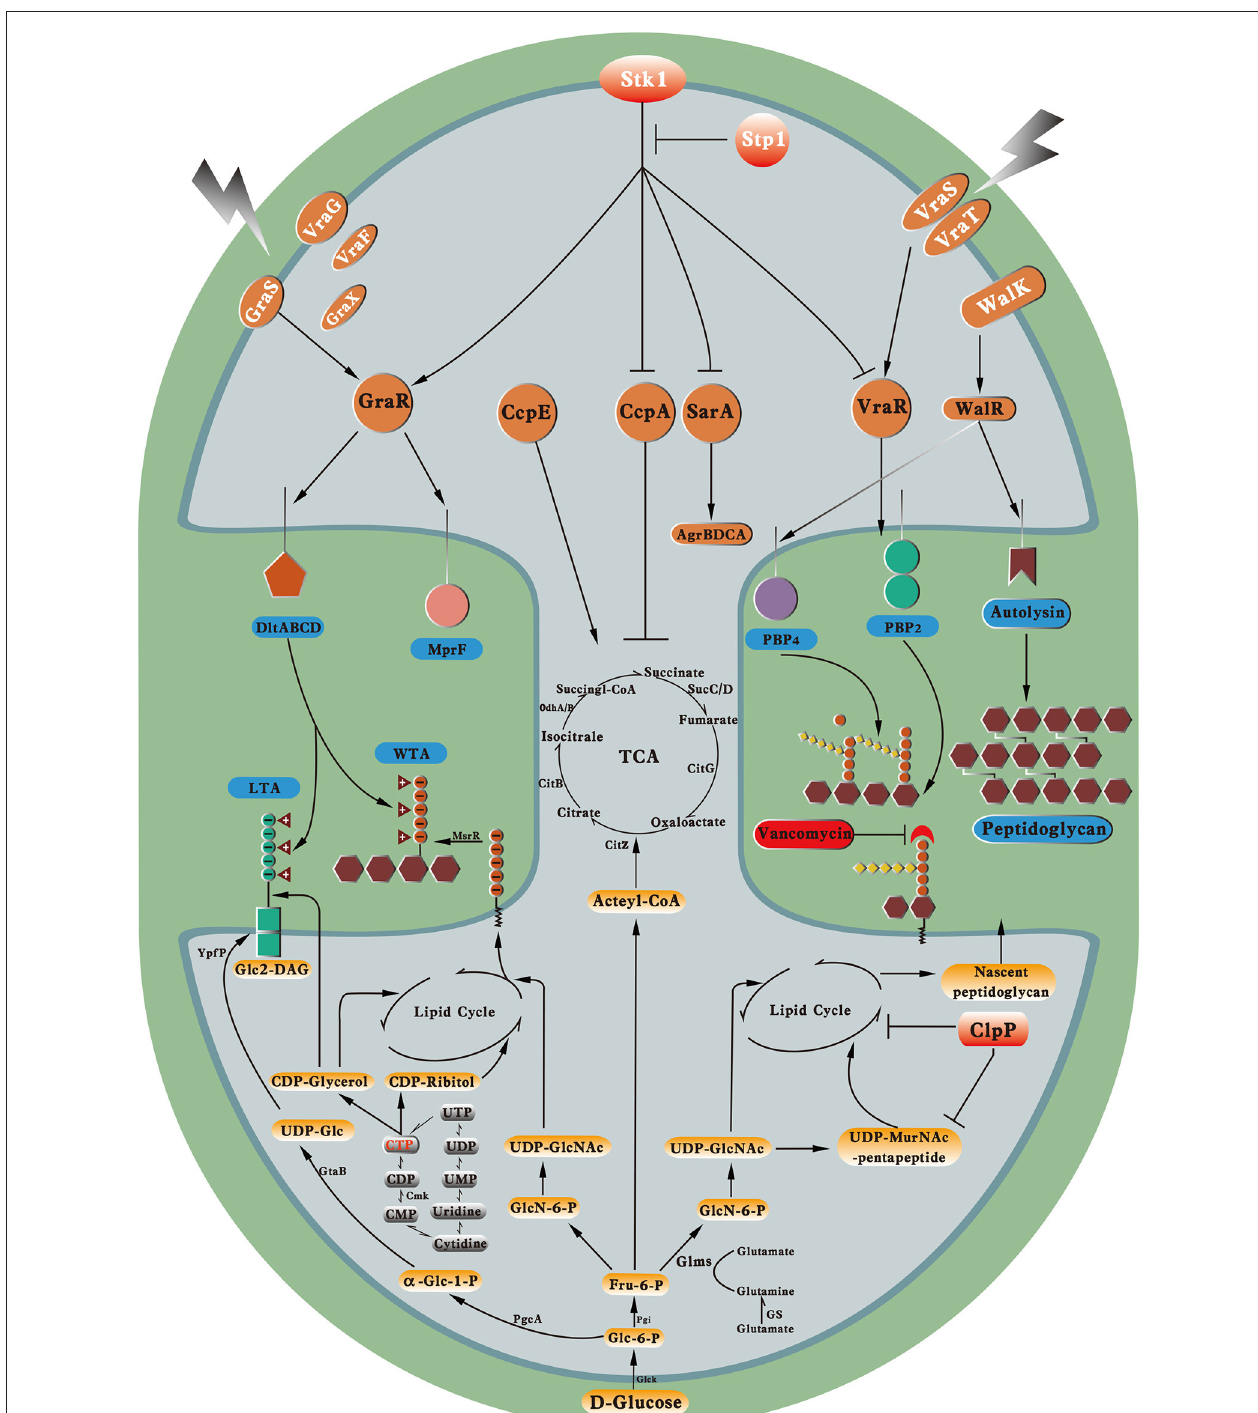
FIGURE 3 | Molecular events in VISA. Key regulatory proteins and cell wall synthesis processes and their enzymes related to vancomycin resistance in VISA. WTA, wall teichoic acid; LTA, lipoteichoic acid; Glc, glucose; GlcN-6-P, glucosamine-6-phosphate; GlcNAc, N-acetylglucosamine; MurNAc, N-Acetylmuramic acid; DAG,